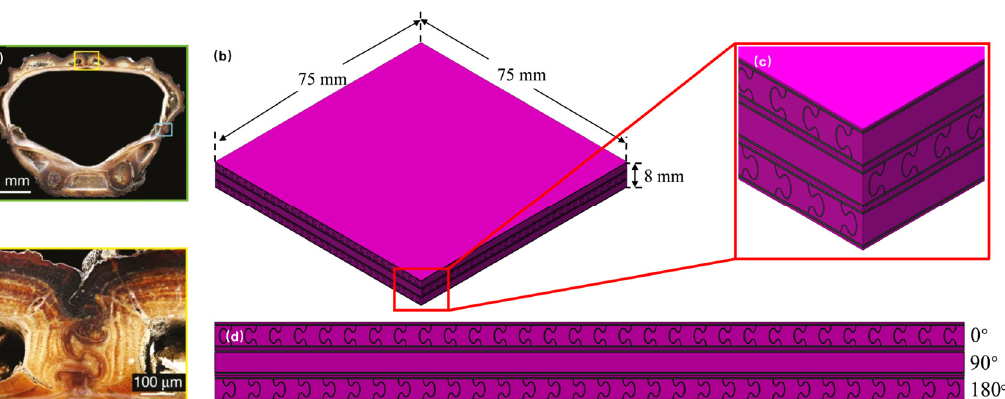
Figure 1. Schematic diagram of Bio-S inspired by mollusk shell [32] ( a ) microstructure of conch shell (Strombus gigas); ( b ) schematic diagram of Bio-S specimen model; ( c ) local feature of bio-S structure; ( d ) the side view of the Bio-S structure.